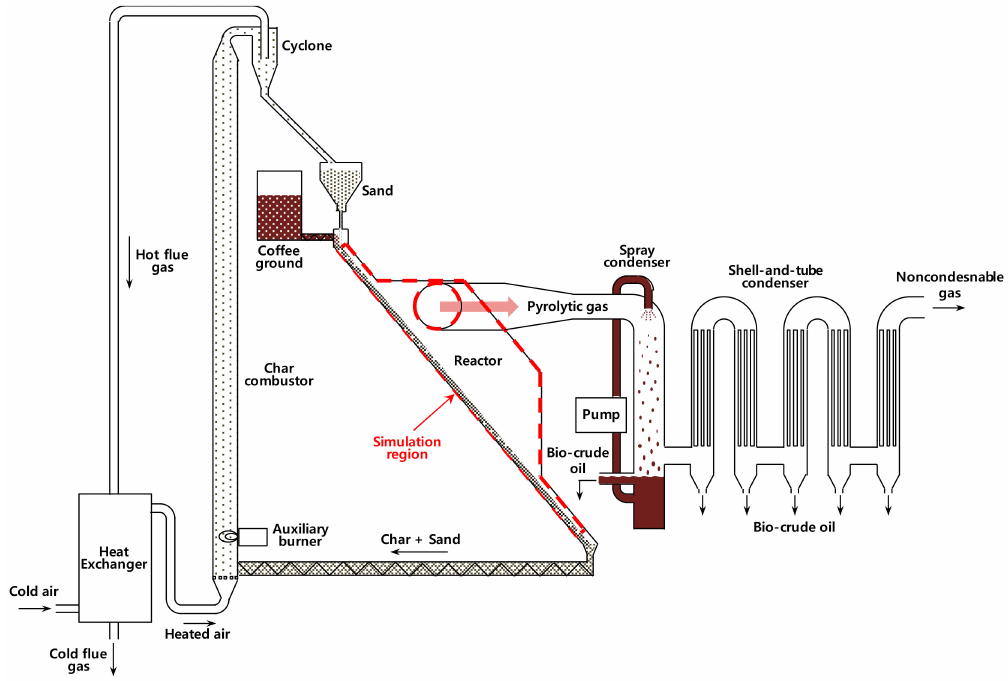
Figure 2. Schematic diagram of the tilted-slide fast